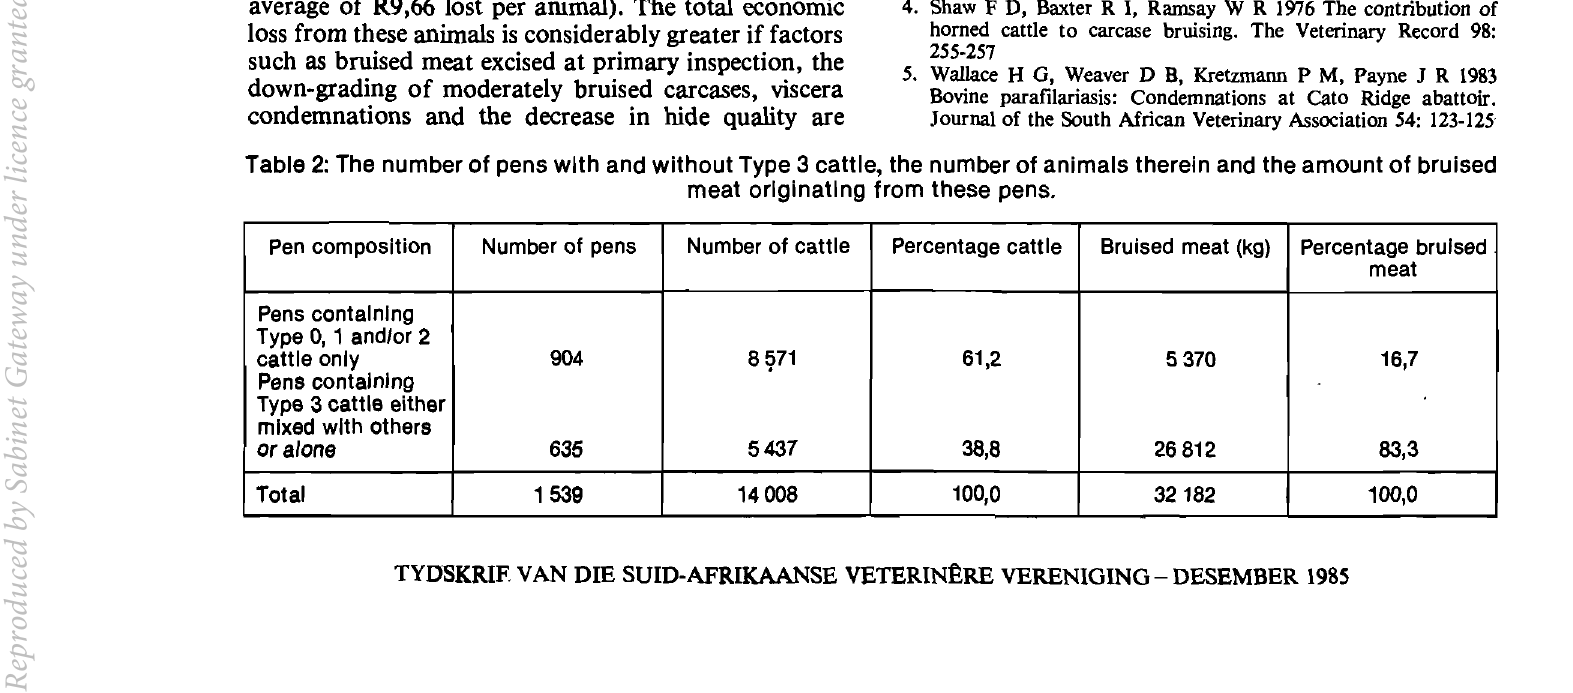
meat originating from these pens.